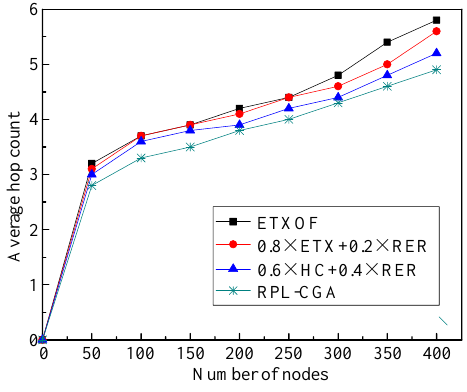
Figure 7. Average hop count.